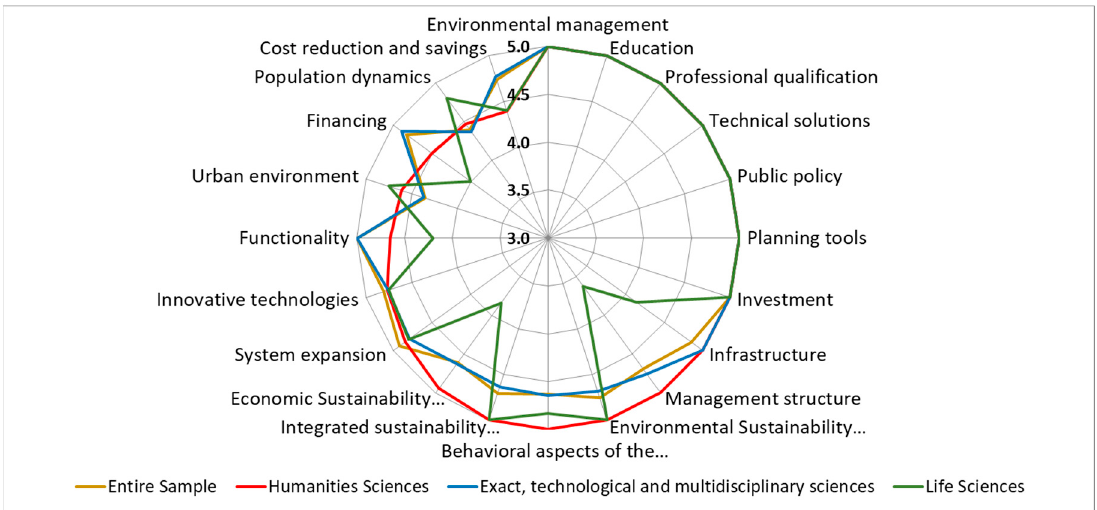
Figure 5. Driver’s behavior for each school of knowledge and the entire sample.